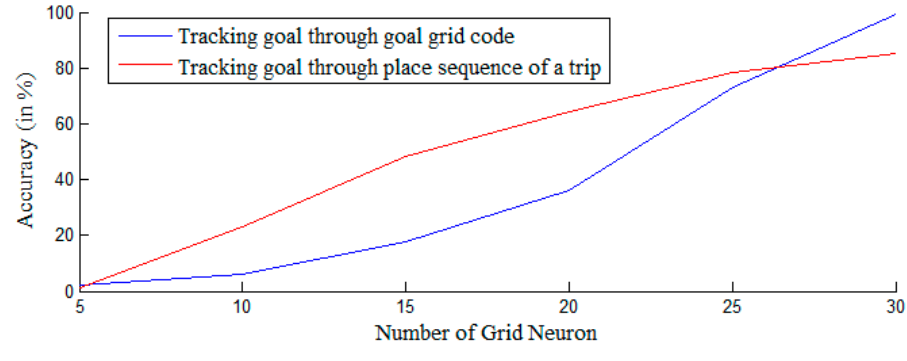
Figure 24. Performance comparison on localization.